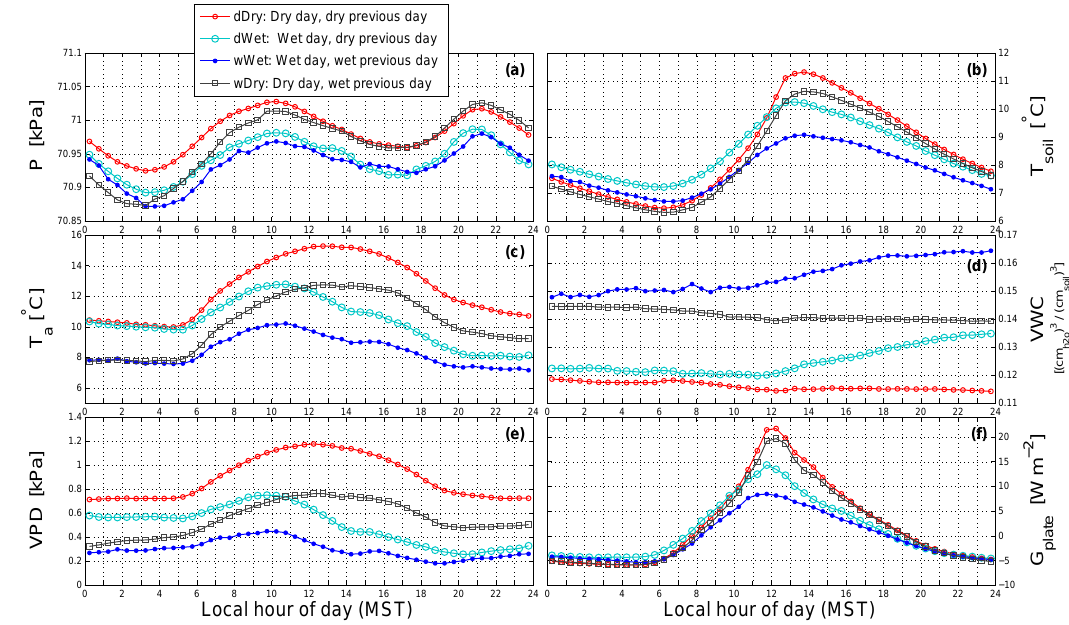
Figure 5. The mean warm-season diel cycle of (a) barometric pressure P , (b) 5cm soil temperature T soil , (c) 21.5m air temperature T a , (d) 5cm soil moisture VWC, (e) 21.5m vapor pressure deficit VPD, and (f) 10cm soil heat flux G plate . Each line represents a different precipitation state as shown in the legend.